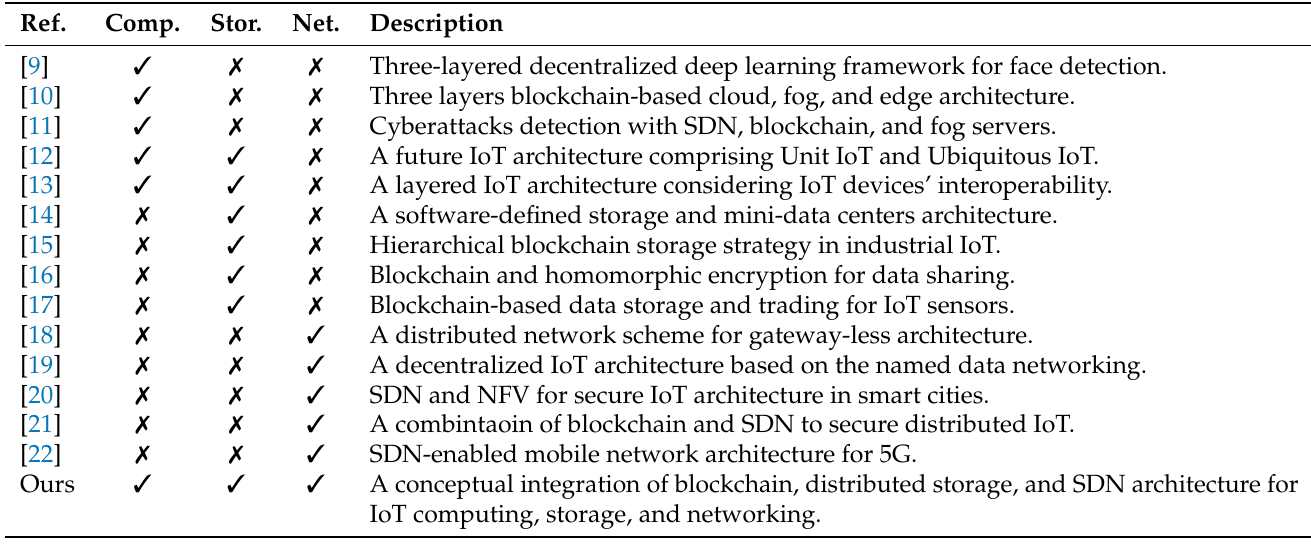
Table 1. The comparison between our proposed architecture and the state-of-the-art based on their decentralization coverage in terms of computing (Comp.), storage (Stor.), and networking (Net.) Ref.